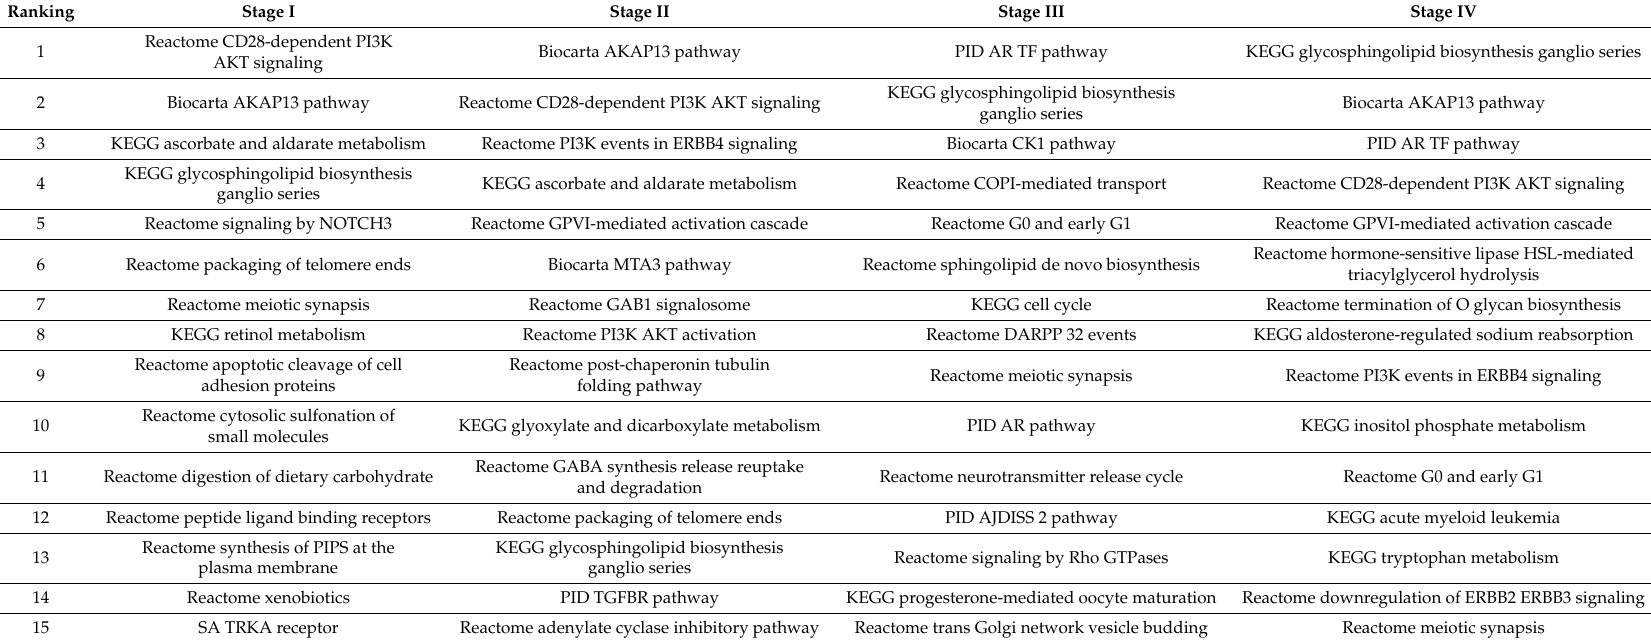
Table 4. The 15 most deregulated canonical pathways in the stage I–IV groups ranked by their p